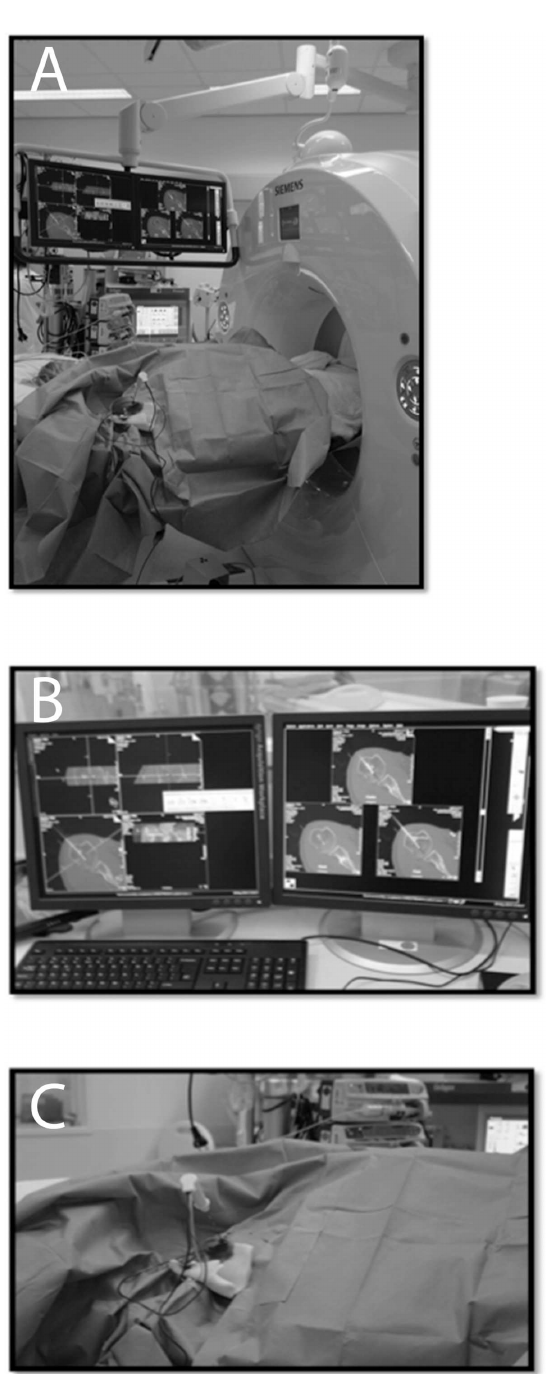
Fig 1. RFA procedure A: Set-up.B: Planningneedleposition.C: Needlein situ duringablation.